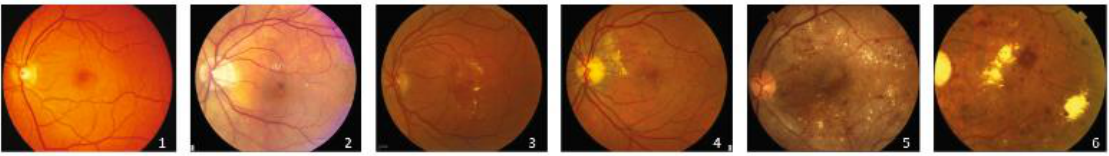
Figure 1. The progress of diabetic retinopathy with image 1 from a mild to a severe case in image 6.